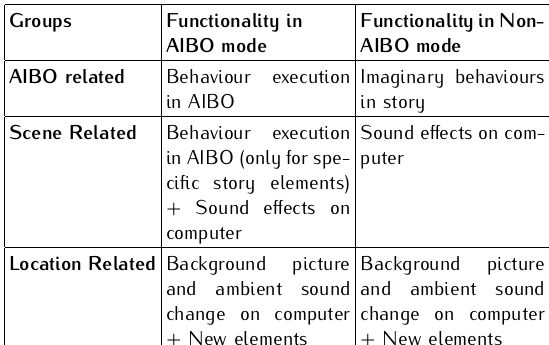
Table 1. Functionalities of elements according to